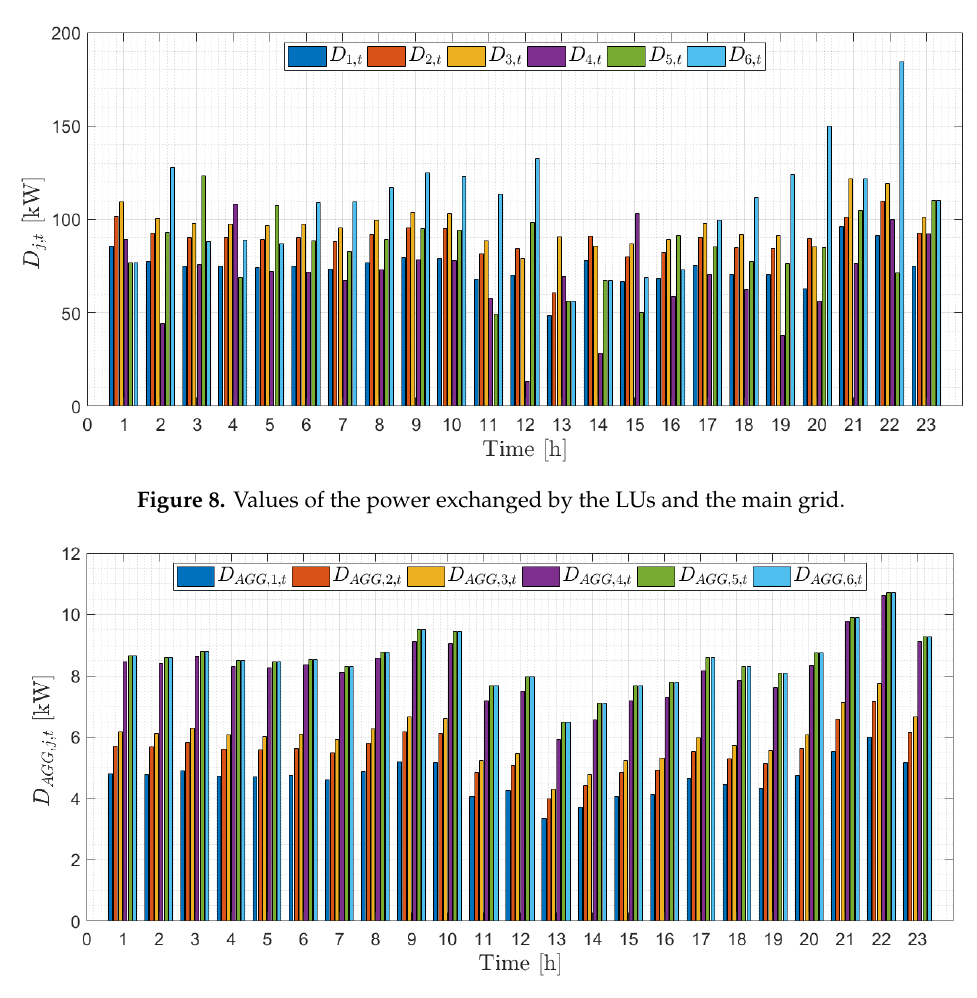
Figure 7. Power reduction at the grid node.